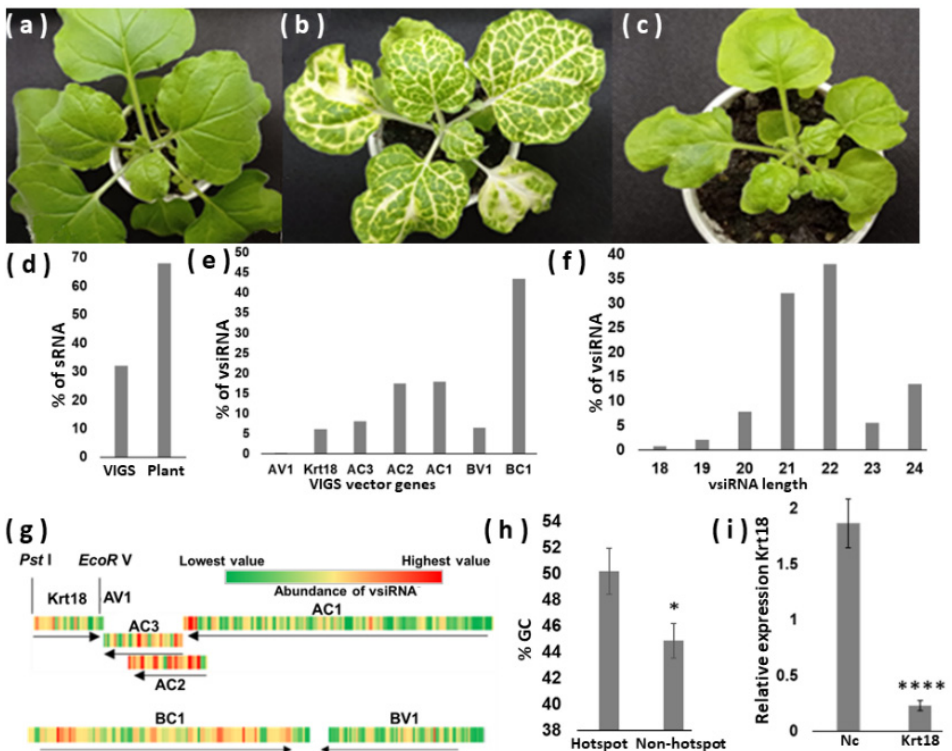
Figure 2. ( a ) Nicotiana benthamiana plant uninfected; ( b ) plant infected with pEuMV-YP: Δ AV1:chlI, the white regions are a consequence of the gene silencing of Magnesium-chelatase subunit I (ChlI); ( c ) plant infected with pEuMV-YP:Krt18 that shows deformations on the edges and slight yellow mosaics; ( d ) percentage of sRNA corresponding to VIGS vector (pEuMV-YP:Krt18) and the plant genes; ( e ) percentage of vsiRNAs derived from genes in pEuMV-YP:Krt18; ( f ) distribution by size of the vsiRNAs of plant infected with pEuMV-YP:Krt18; ( g ) heatmap of the pEuMV-YP:Krt18 genome, the red color represents a greater accumulation of vsiRNA, the gold color represents those of medium accumulation, while the green color represents less accumulation; ( h ) average GC content in VIGS vector regions with highest and lowest of vsiRNA accumulation (hotspots and nonhotspots, respectively); t -test * p -value < 0.01; ( i ) vsiRNA-induced silencing of the Krt18 gene in macrophages of Mus musculus , being Nc sRNA from plants 28 days postinoculation (dpi) with pEuMV-YP: ∆ AV1:chlI, and Krt18 is sRNA from plants 28 dpi with pEuMV-YP: Krt18; t -test **** p -value < 0.00001. Sequencing analysis showed that 21, 22, and 24 nt RNAs were the most abundant (83%) in the VIGS vector genome (Figure 2f). The vsiRNA sequences were differentially accumulated throughout the VIGS vector genome, as shown in the heatmap in Figure 2g. The red color indicates that in that region of the VIGS vector, there was a high accumulation of vsiRNA (hotspot), the gold color, an intermediate accumulation, and the green color, a low accumulation (nonhotspot). When analyzing hotspots, we found that the average GC content is higher than nonhotspots, as shown in Figure